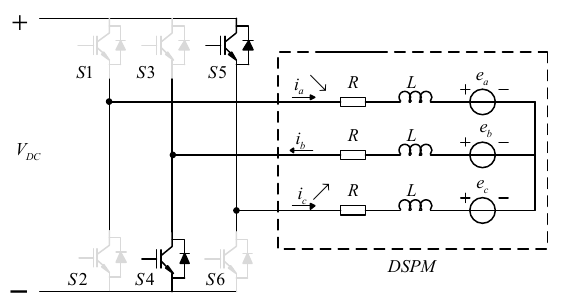
Figure 4. The commutation from phase A to phase C.